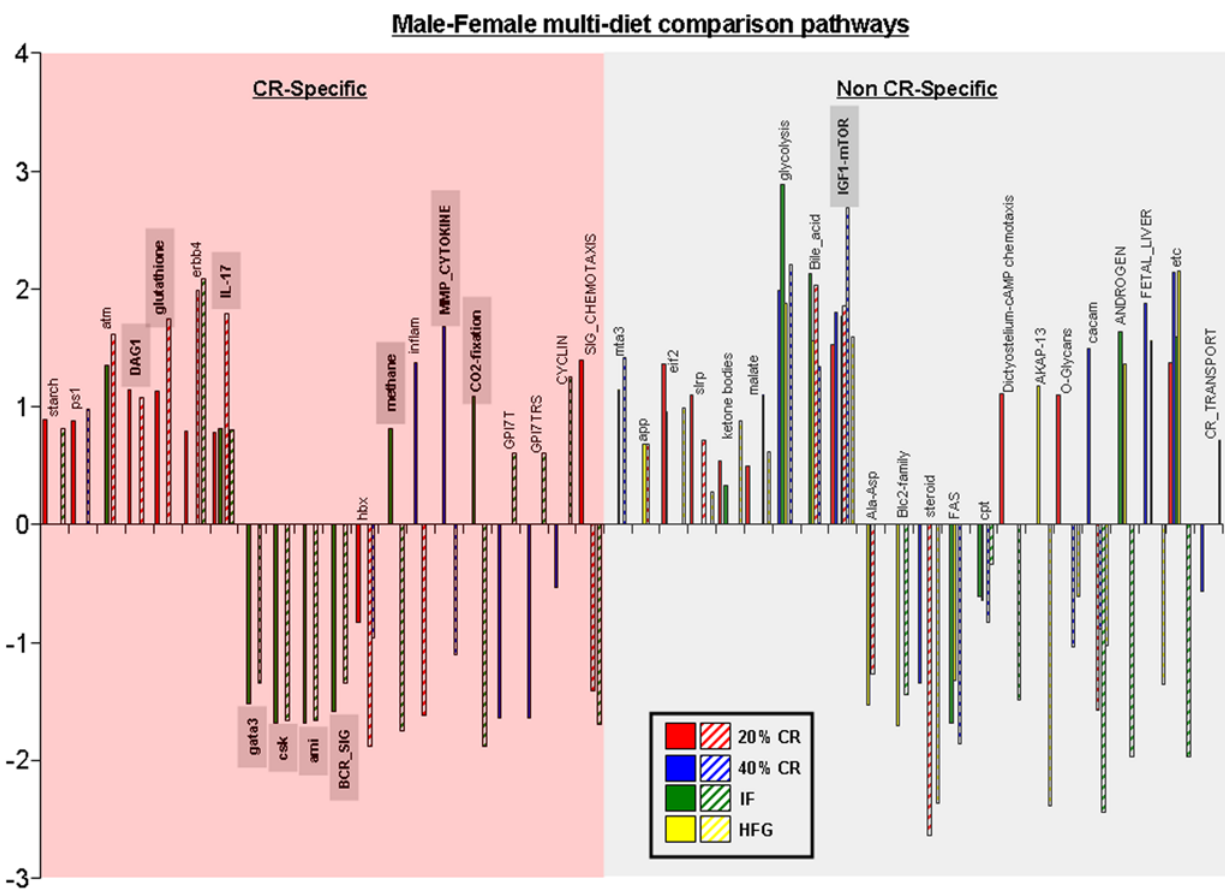
Figure 14. Caloric specificity of male-female common multi-diet regulated pathways. Significantly altered functional pathways that were common between diet paradigms and both genders were drawn to visualize caloric specificity. Names of the significantly altered pathways can be found in Table S2.